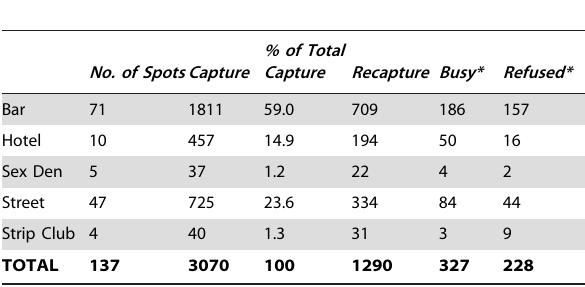
Table 1. Breakdown of SW enumerated at each type of hot